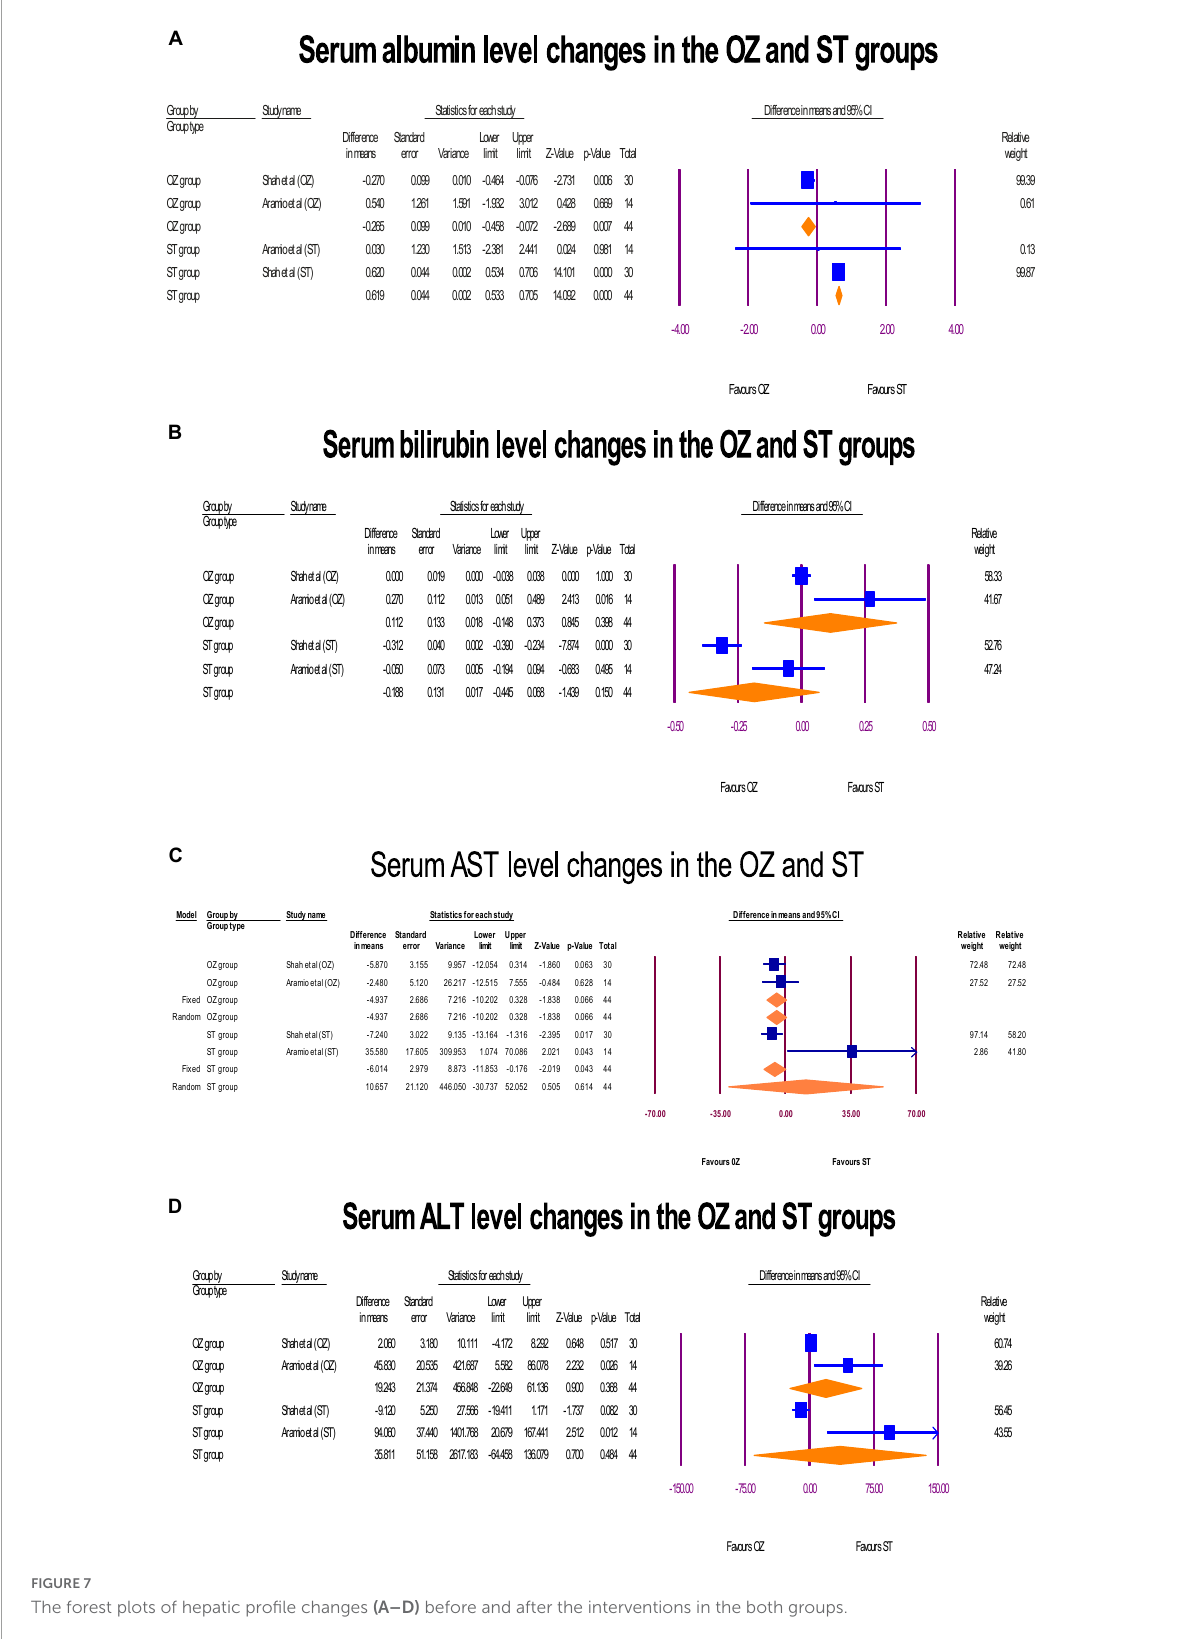
FIGURE7 The forest plots of hepatic profile changes (A–D) before and after the interventions in the both